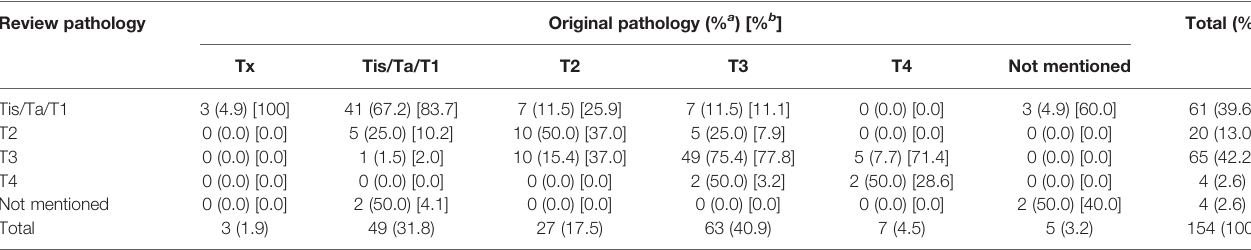
TABLE 3 | Interobserver variation for pathological T stage. Review pathology